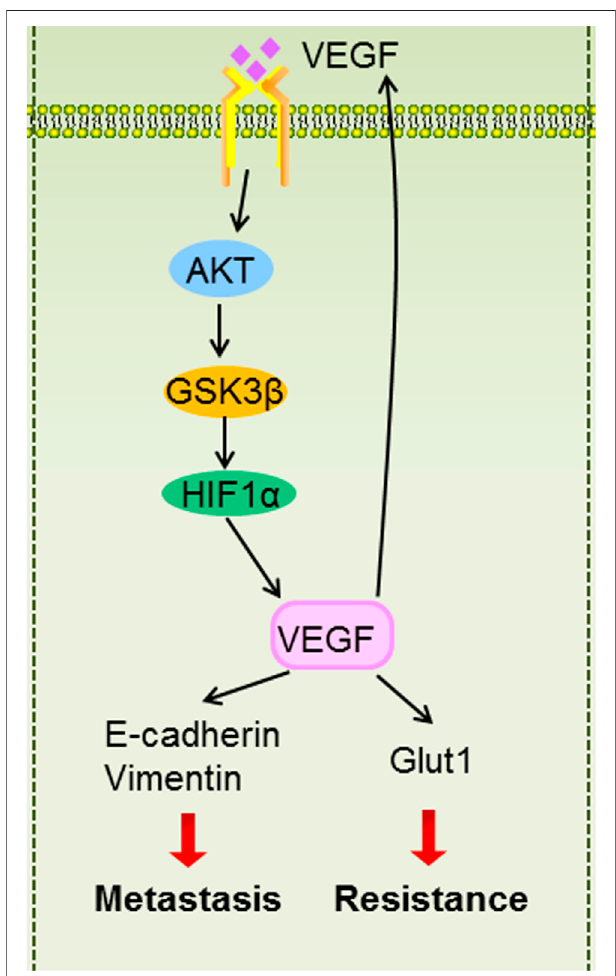
FIGURE 9 | The graphic illustration of HIF1 α /VEGF feedback loop contributes to 5-Fu resistance and metastasis in CRC.